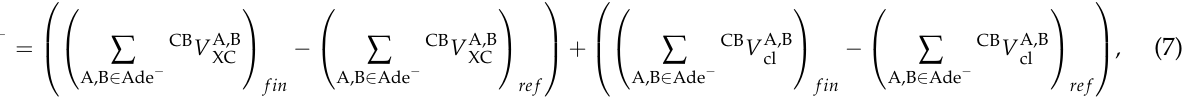
− ) calculated for int